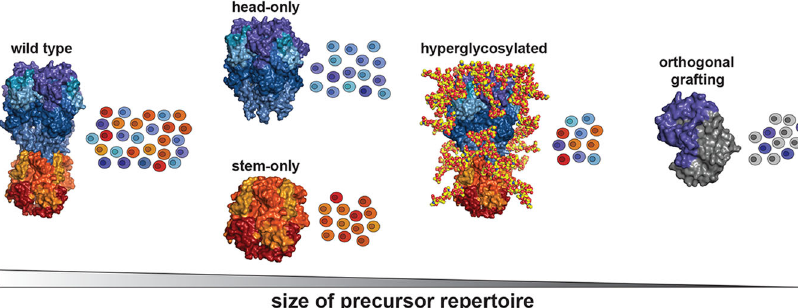
Fig. 1 Modulating precursor repertoire with various immunogen design strategies. Schematic representation of how precursor frequency may be altered using different protein engineering strategies to remove ‘ off-target ’ competing clones using in fl uenza hemagglutinin (HA) as a representative example. Colors refer to theoretical epitopes on full length HA; shades of blue and purple correspond to head-directed epitopes; shades of yellow, orange, and red correspond to stem-directed epitopes. For orthogonal grafting, a hypothetical scaffold is shown in gray with purple region illustrating a grafted HA head epitope. All images created in PyMol using PDB